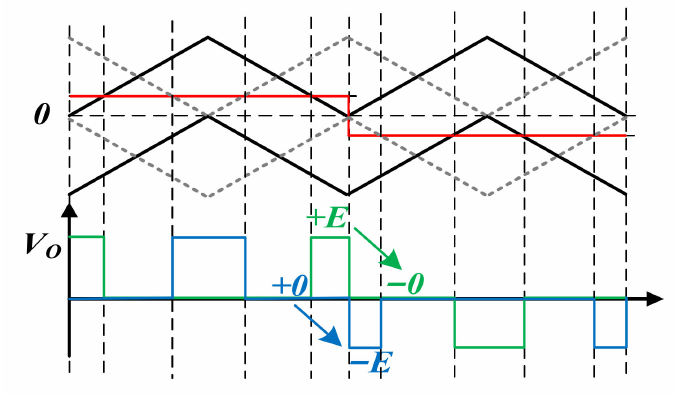
Figure 3. Switching process at zero crossing point.